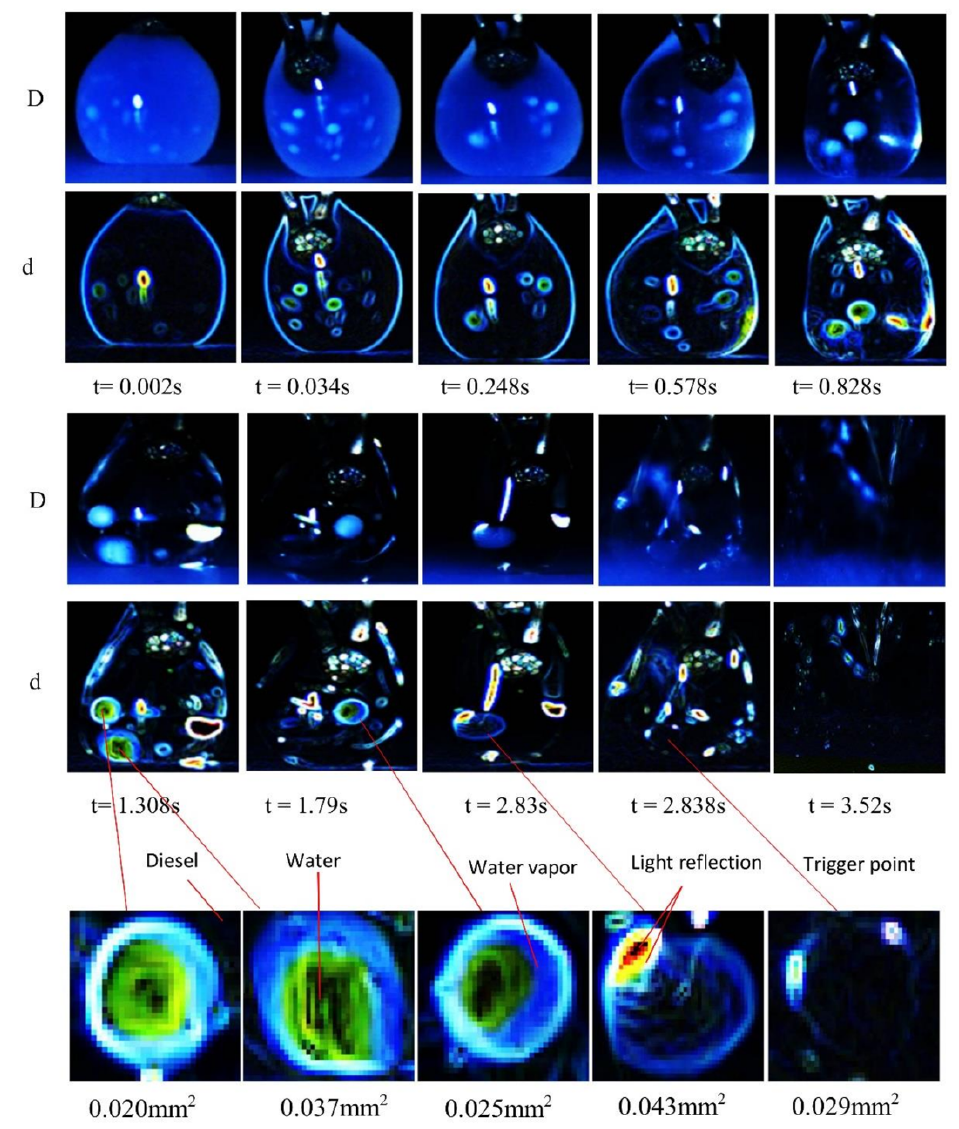
Figure 8. Droplet heating behavior during of emulsion: D (raw image) and d (processed image).